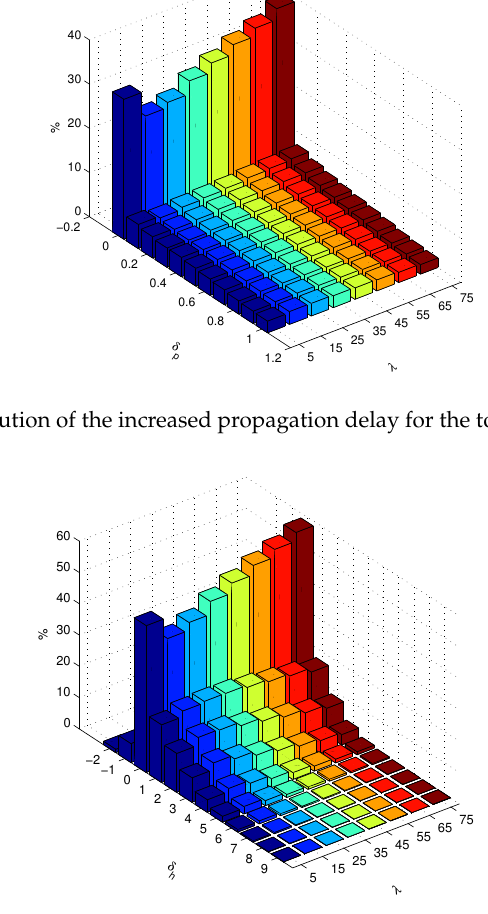
Figure 10. The distribution of the increased number of hops for the topology set with D = 4.